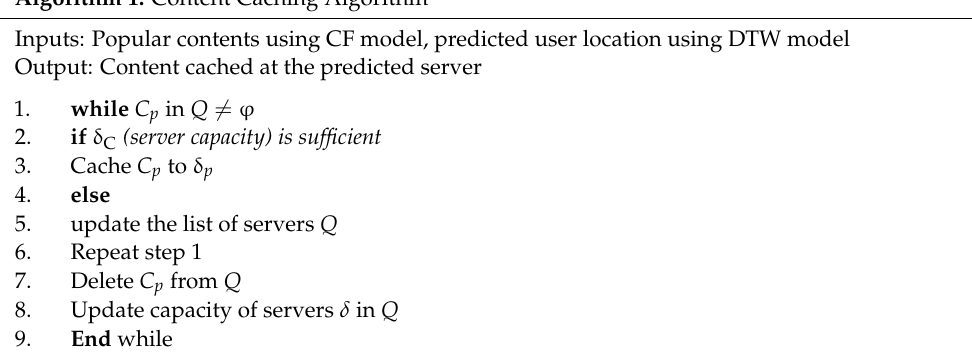
Algorithm 1: Content Caching